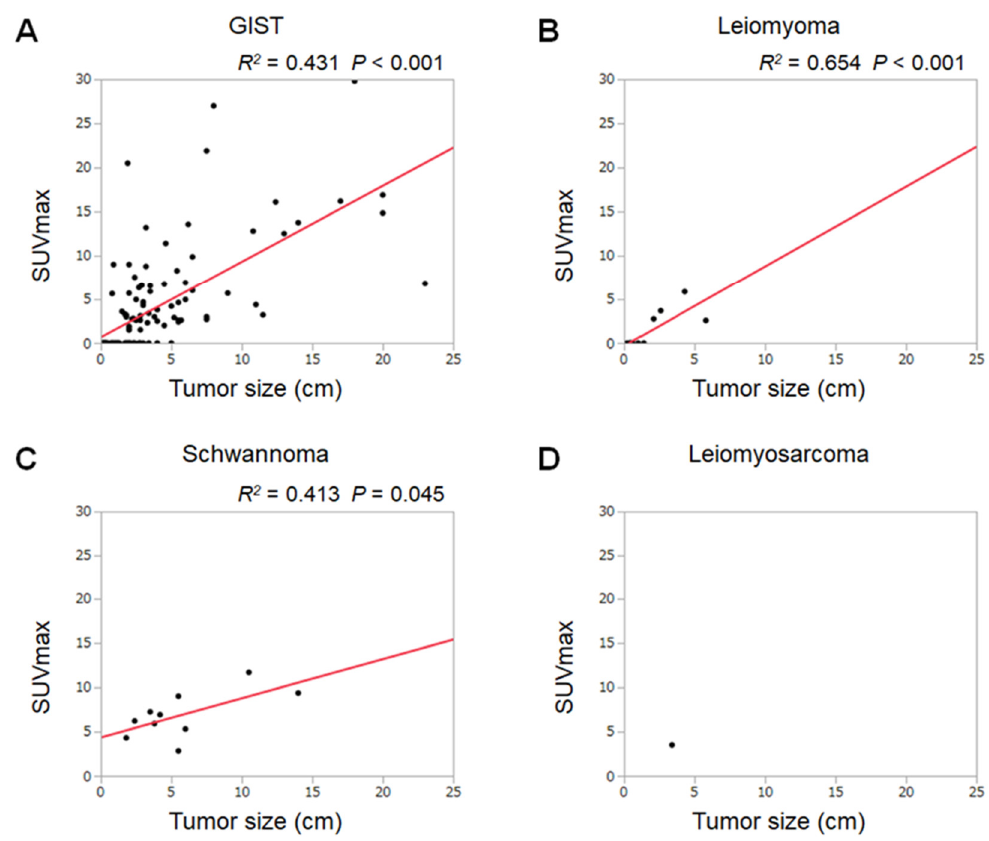
Figure 3. Scatter diagrams and regression lines with respect to tumor sizes and the SUVmax of GISTs ( A ), leiomyomas ( B ), schwannomas ( C ), and leiomyosarcoma ( D ).